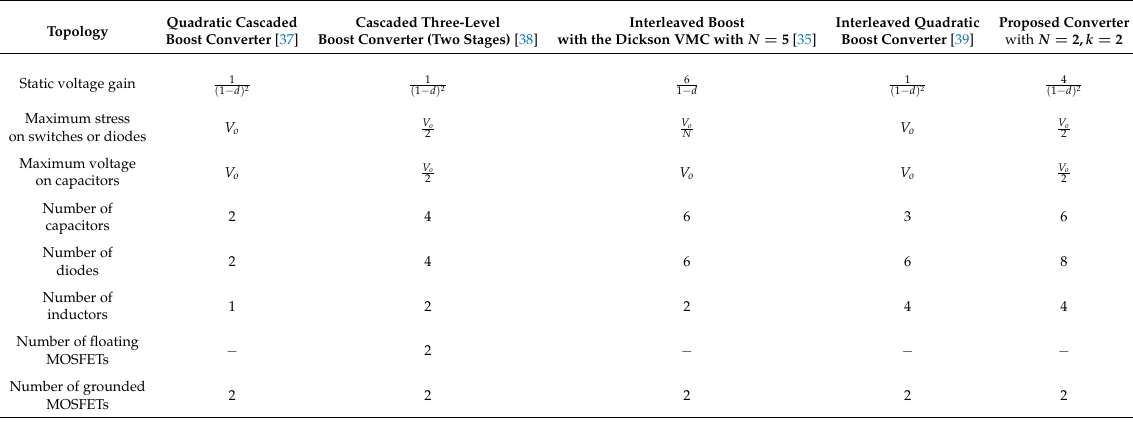
Table 2. Comparison between different